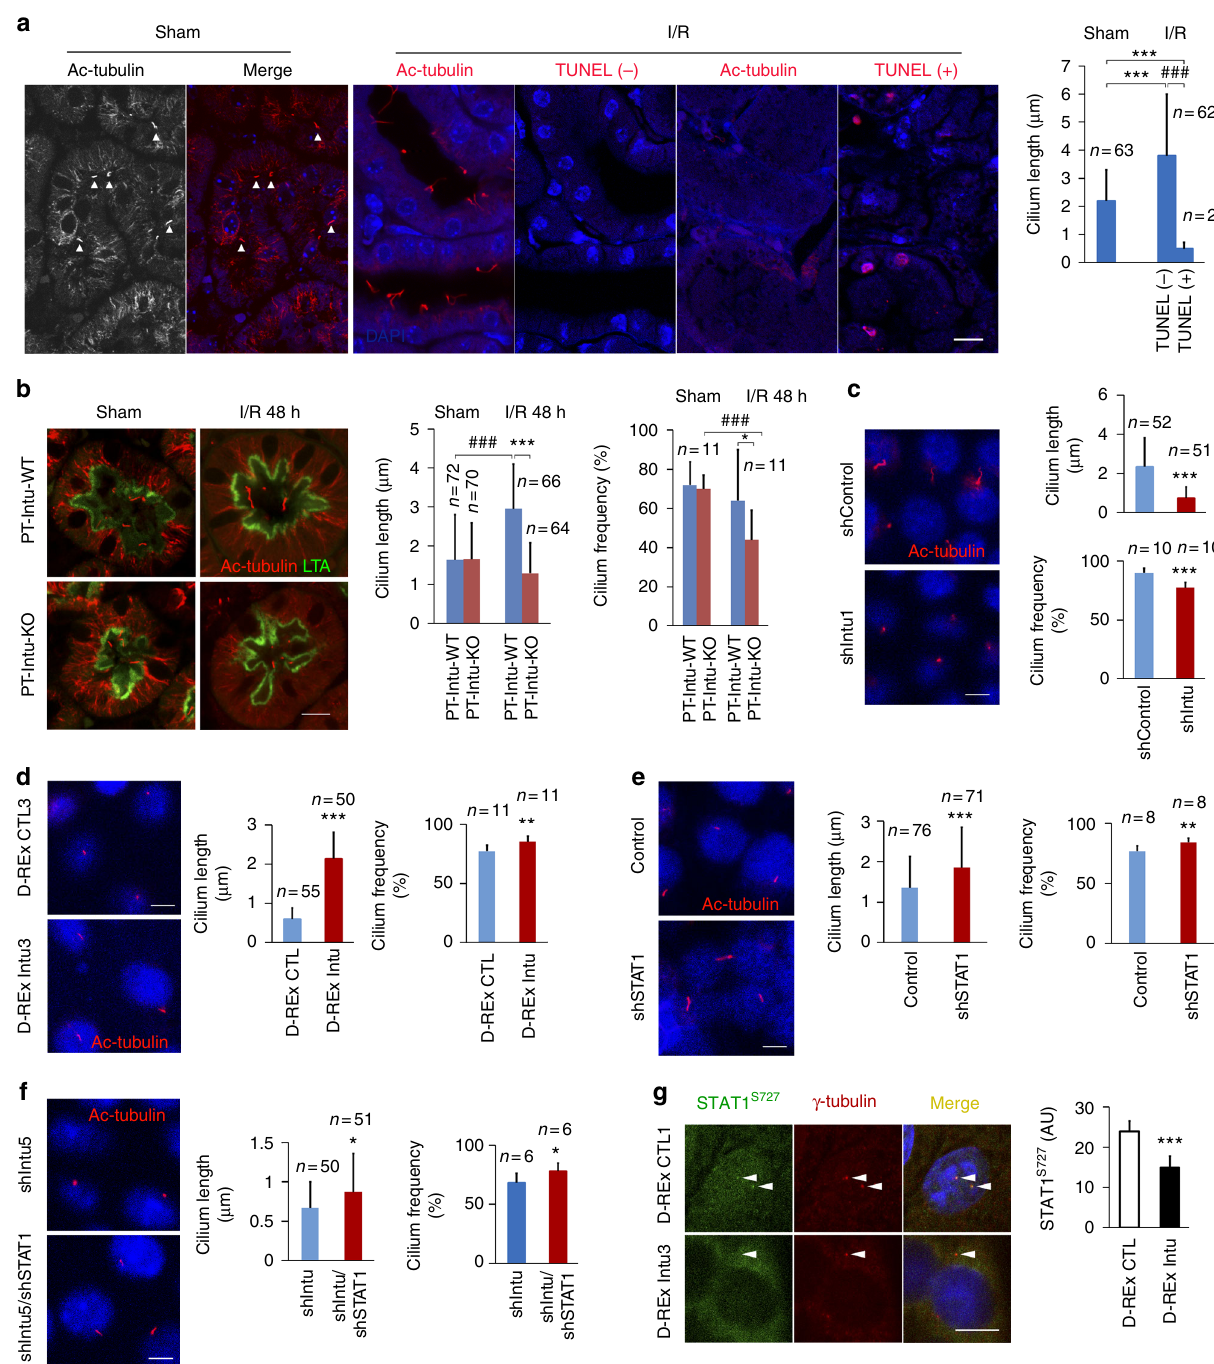
Fig. 7 Regulation of primary cilia by Intu and STAT1. a Cilium length and cell death in kidney tubules during renal IRI in mice. WT mice were subjected to sham operation or 35 min of ischemia with 48 h of reperfusion to harvest kidneys for Ac-tubulin immuno fl uorescence staining and TUNEL assay. TUNEL- negative tubules in injured tissues had longer cilia compared to sham controls, while TUNEL-positive tubules had shorter cilia. White triangle denotes cilia. b Ac-tubulin and LTA staining showing cilium length and frequency in proximal tubules after renal IRI in WT mice that was attenuated in PT-Intu-KO mice. c Ac-tubulin staining showing shortened cilia and lower frequency in Intu-knockdown cells (shIntu), compared to control shRNA-transfected cells (shControl). d Intu overexpression (D-REx Intu3) preserved cilium length during azide treatment. e Longer cilia and higher cilium frequency in STAT1- knockdown cells as compared to control cells. f Intu/STAT1 double knockdown cells had longer cilium than Intu only knockdown cells. g Double immuno fl uorescence of serine 727 phosphorylated STAT1 and γ -tubulin (centriole marker) to show that inducible Intu expression abolished centriole- associated STAT1. Fluorescence signal was quanti fi ed with ImageJ ( n = 7). n is the number of cilia ( a – f ) or centrioles ( g ). Quantitative data are mean ± s.d. (error bars). Grouped t test was used. * p < 0.05, ** p < 0.01, *** p < 0.001, ### p < 0.001. Scale bar ( µ m): 10 ( a , b , g ), 5 ( c – f